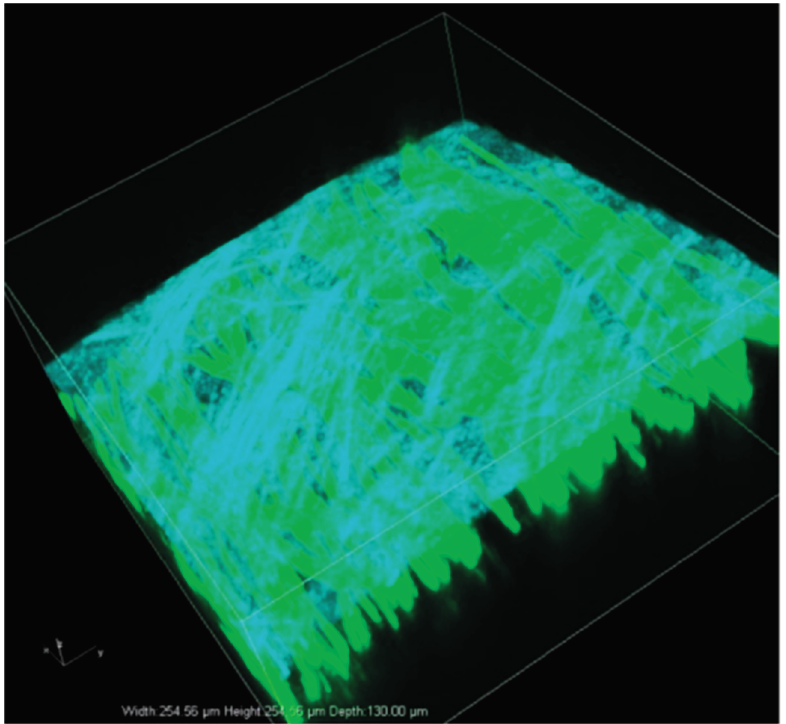
Figure 2. Intact normal axons in the dorsal funiculi of YFP H-line mice were observed by two-photon excitation microscopy. Blue color represents the SHG signal from the dura, which covered the surface of the spinal cord. The green signal represents the YFP fluorescence signal. Image acquisition was performed in an area of 254.5 × 254.5 μ m at seconds per frame. A three-dimensional volume-rendering image was constructed using the z-stack